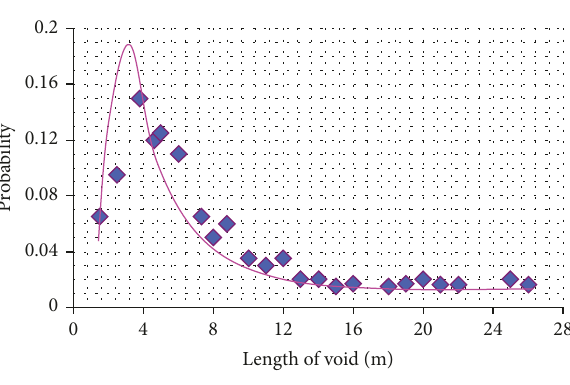
Figure 15: Length distribution of liner voids.